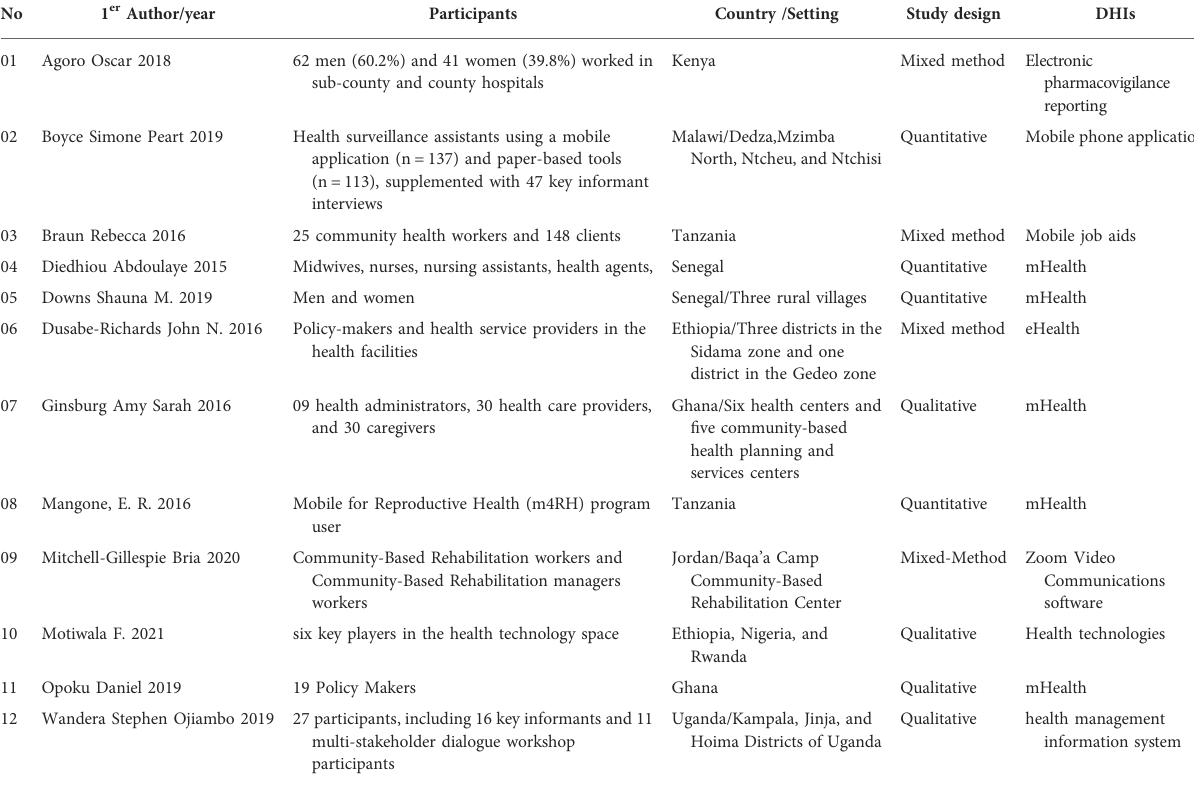
TABLE 1 Characteristics of included articles ( n